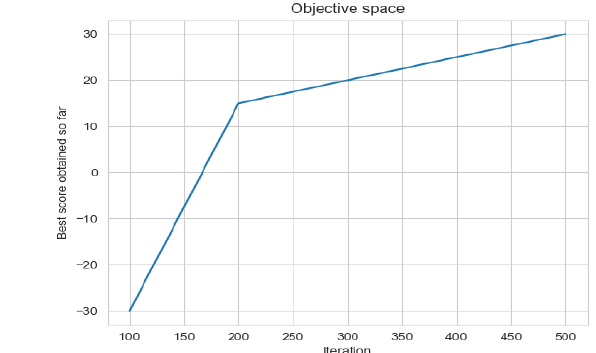
Figure 10. For function-F4 the convergence curve has shown.